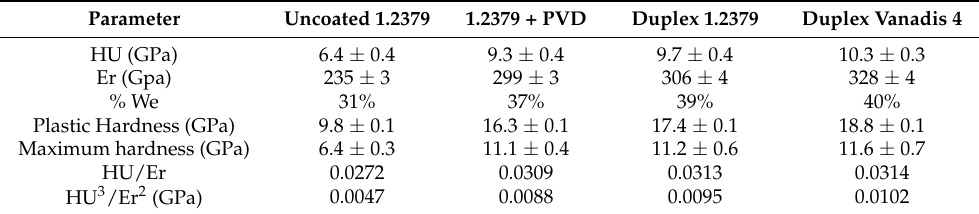
Table 4. Summary of the experimental data derived from the ultra-microhardness tests at 500 mN: hardness (HU), elasticity (Er), elastic deformation work percentage (% We), plastic hardness, maxi- mum hardness, and H/Er and H 3 /Er 2 ratios.